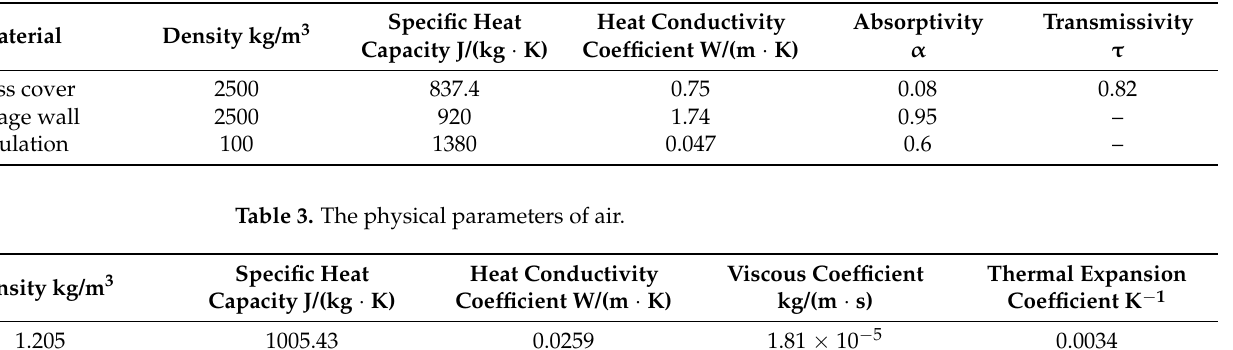
Table 2. The physical parameters of the main materials.